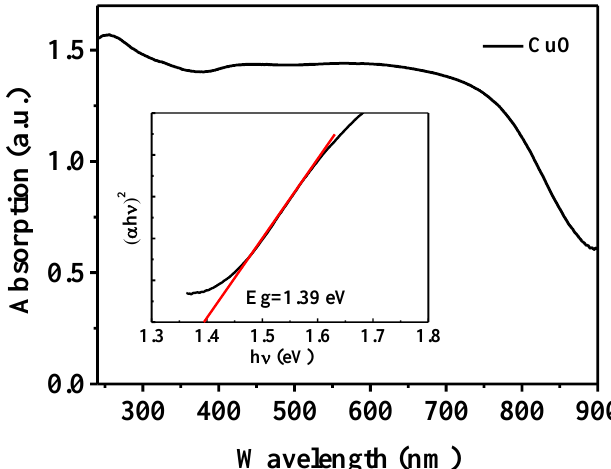
Figure 7. The UV‒Vis absorption spectra and Tauc plot of mesoporous CuO. Figure 7. The UV–Vis absorption spectra and Tauc plot of mesoporous CuO.